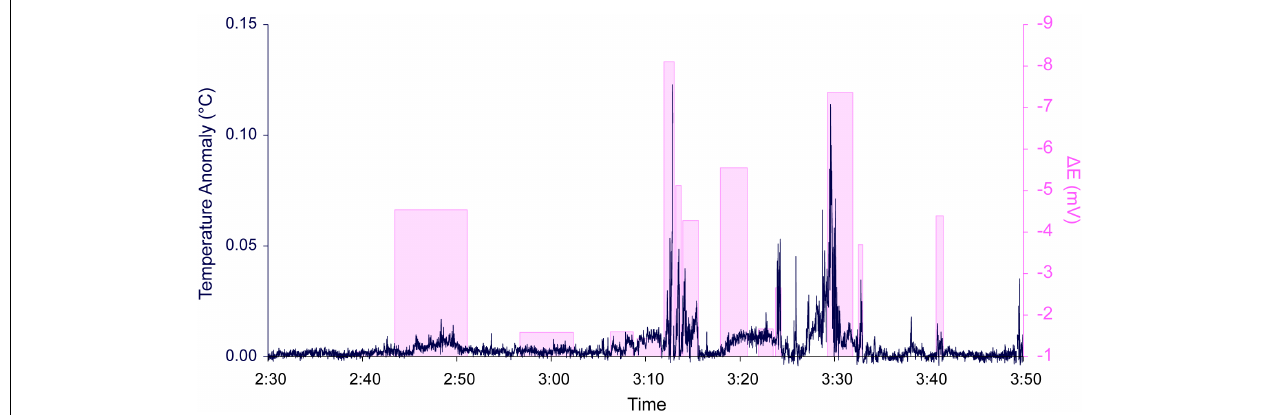
FIGURE 12 | Time-series data from MAPR instrument on ROV SuBastian dive S45 showing that temperature and (cid:49) E anomalies (black line and pink bars, respectively) are well-correlated, providing evidence of weak hydrothermal activity associated with the new lava flow. The largest anomalies are where the ROV crossed over the thickest parts of the pillow mound within the second area of depth change (see Figure 10 ). This was the same time interval when thick accumulations of hydrothermal sediments were observed ( Figure 11f ) along with occasional sightings of vent